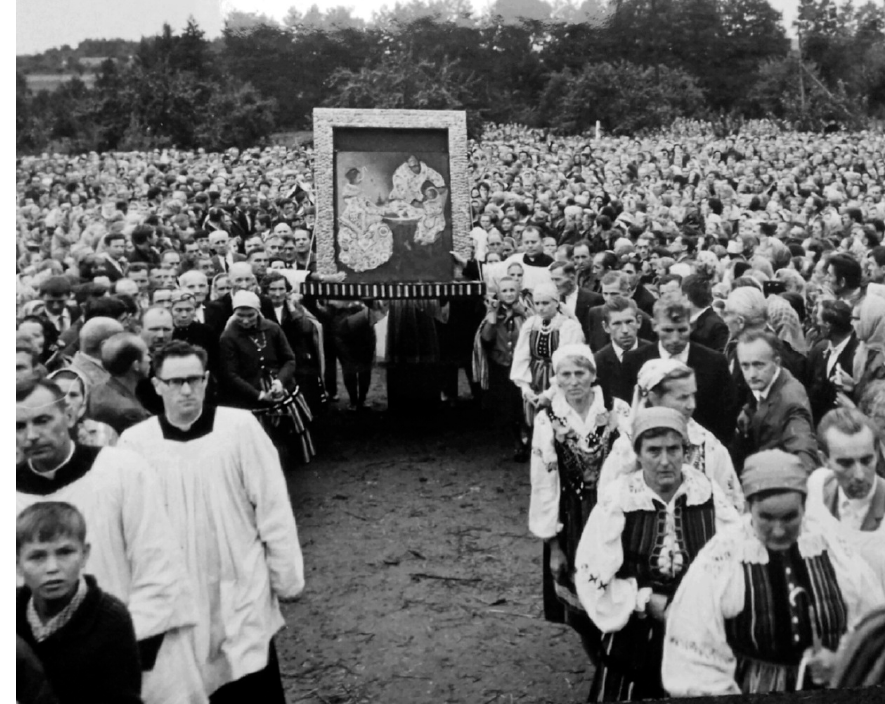
Figure 12. Celebrations of the coronation of the miraculous image of the Holy Family in Studzianna (18 August 1968) (photo: Archive of the Holy Family Sanctuary in Studzianna).